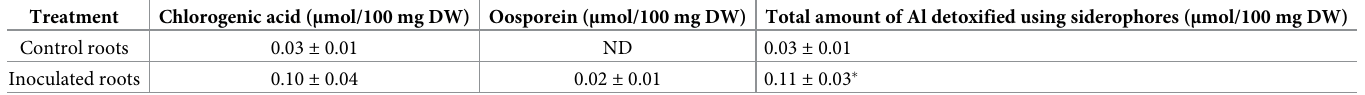
Table 3. Siderophores contribution to Al detoxification in control roots and inoculated roots with Chaetomium cupreum .